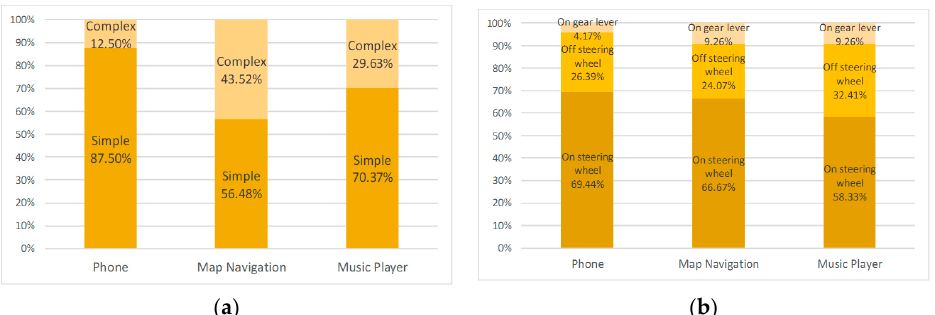
Figure 5. Observed percentages of wrist and touch gestures for the commands used in our study ( a ) Complexity—Simple gestures were highly preferred for phone category; ( b ) Locale—on-steering wheel gestures were highly preferred for all three categories. Multimodal Technol. Interact. 2019 , 3 , x FOR PEER REVIEW